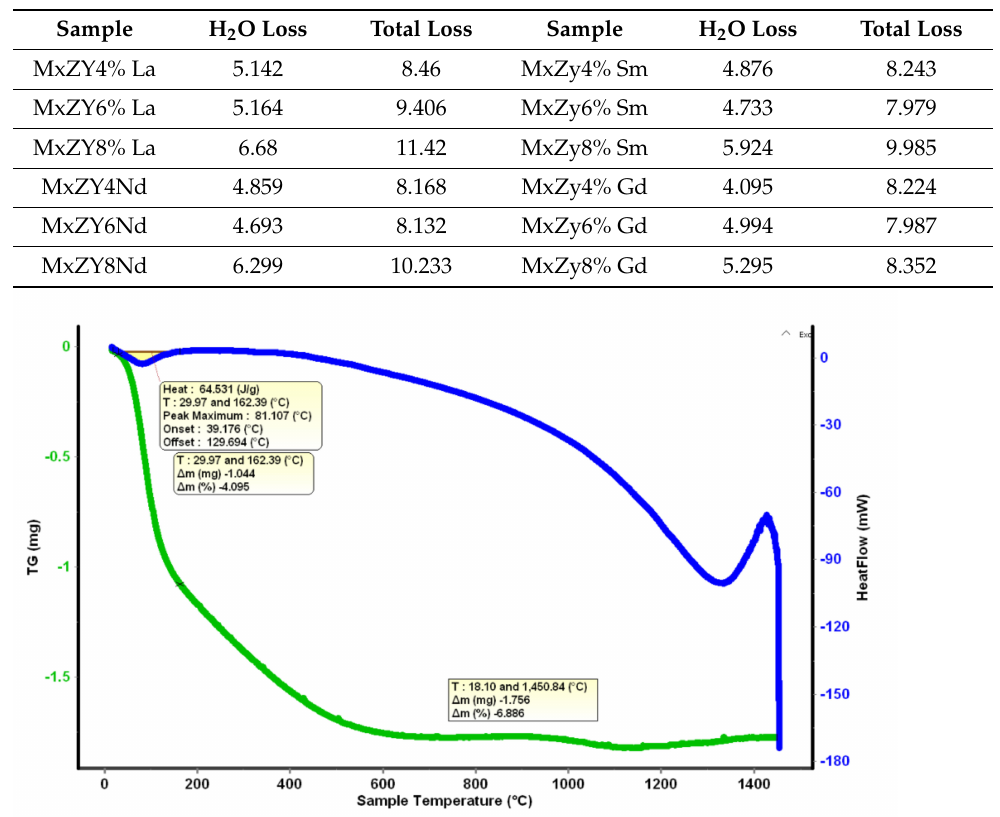
Figure 5. DSC-TG analysis of MxZY4% Gd powder.